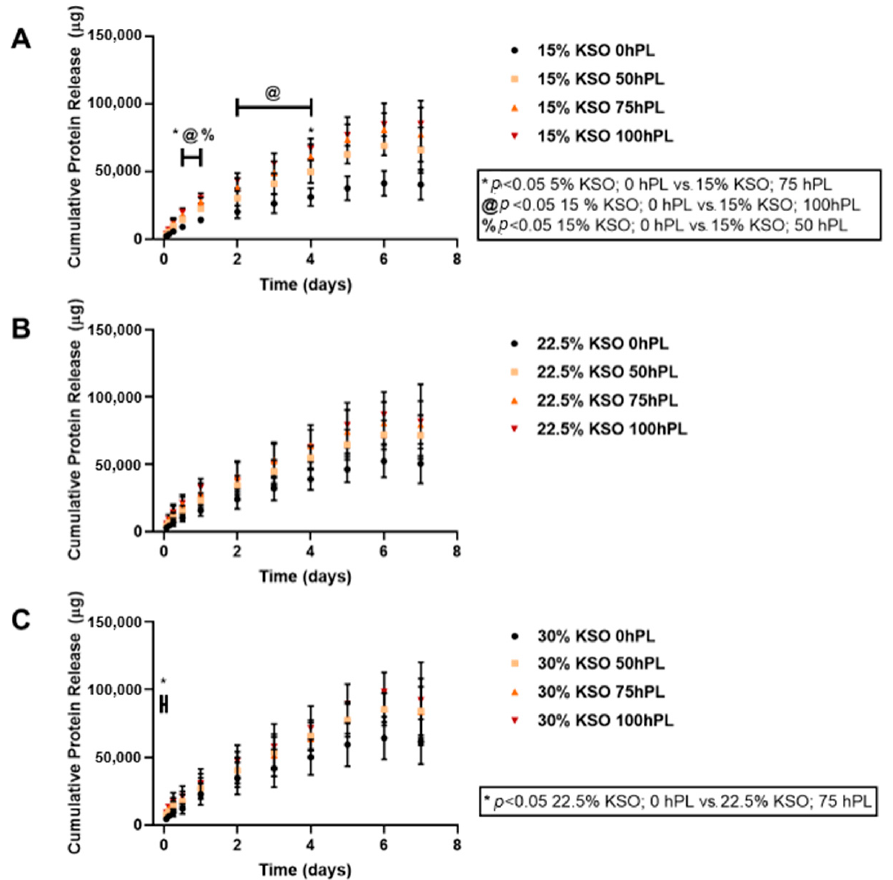
Figure 2. Total protein release against varying hPL-loading concentrations. Total protein release against varying hPL-loading concentrations was quantified by BCA assay and plotted for 15% ( A ), 22.5% ( B ), and 30% ( C ) KSO weight percentage hydrogels. Increase in hPL concentration increased total protein release.